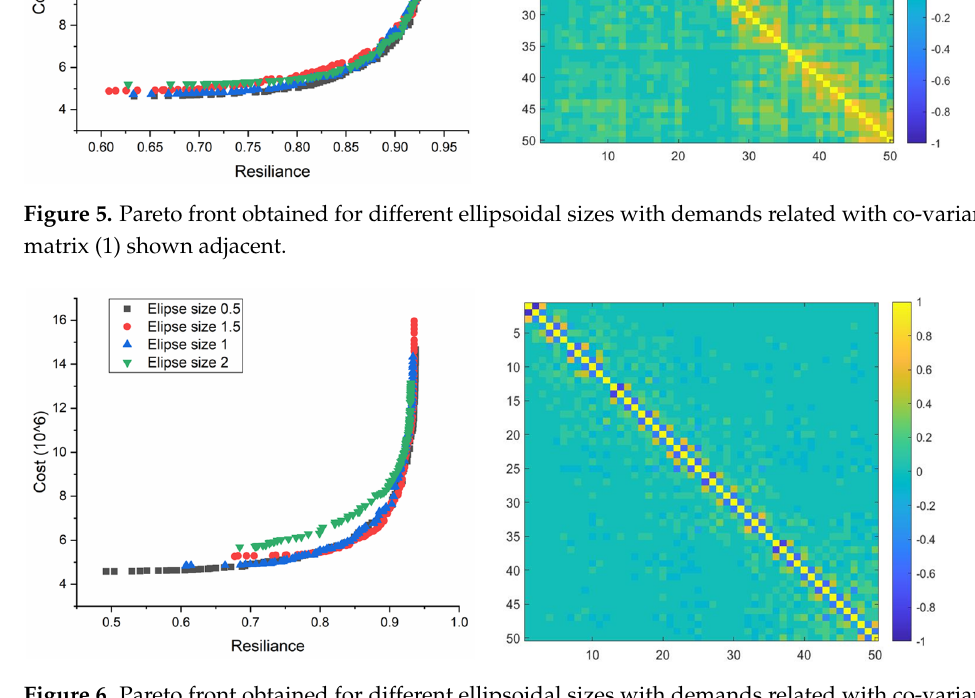
Figure 6. Pareto front obtained for different ellipsoidal sizes with demands related with co-variance matrix (2) shown adjacent.